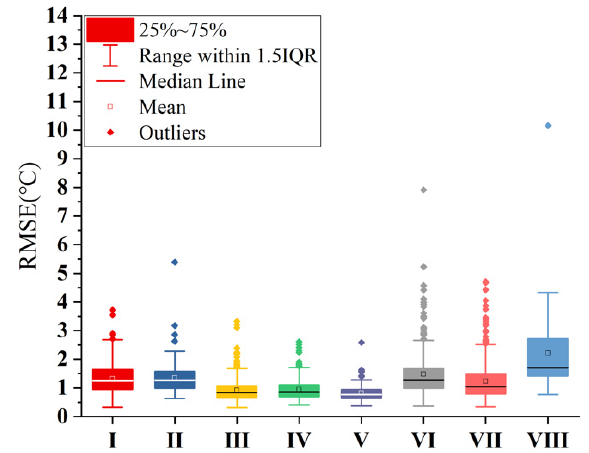
Figure 10. Box plot of RMSE for analysis data in different regions.